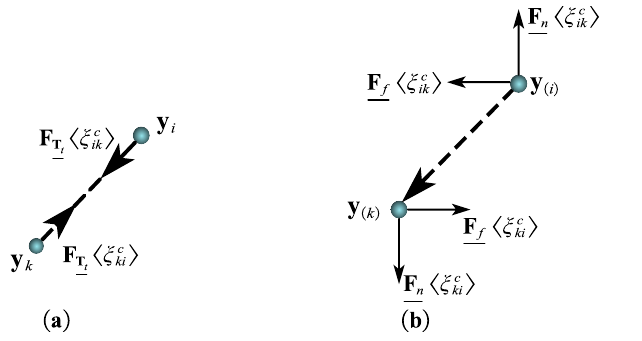
Figure 4. The formation of peridynamic contact pair in two conditions. ( a ) Sticking. ( b )